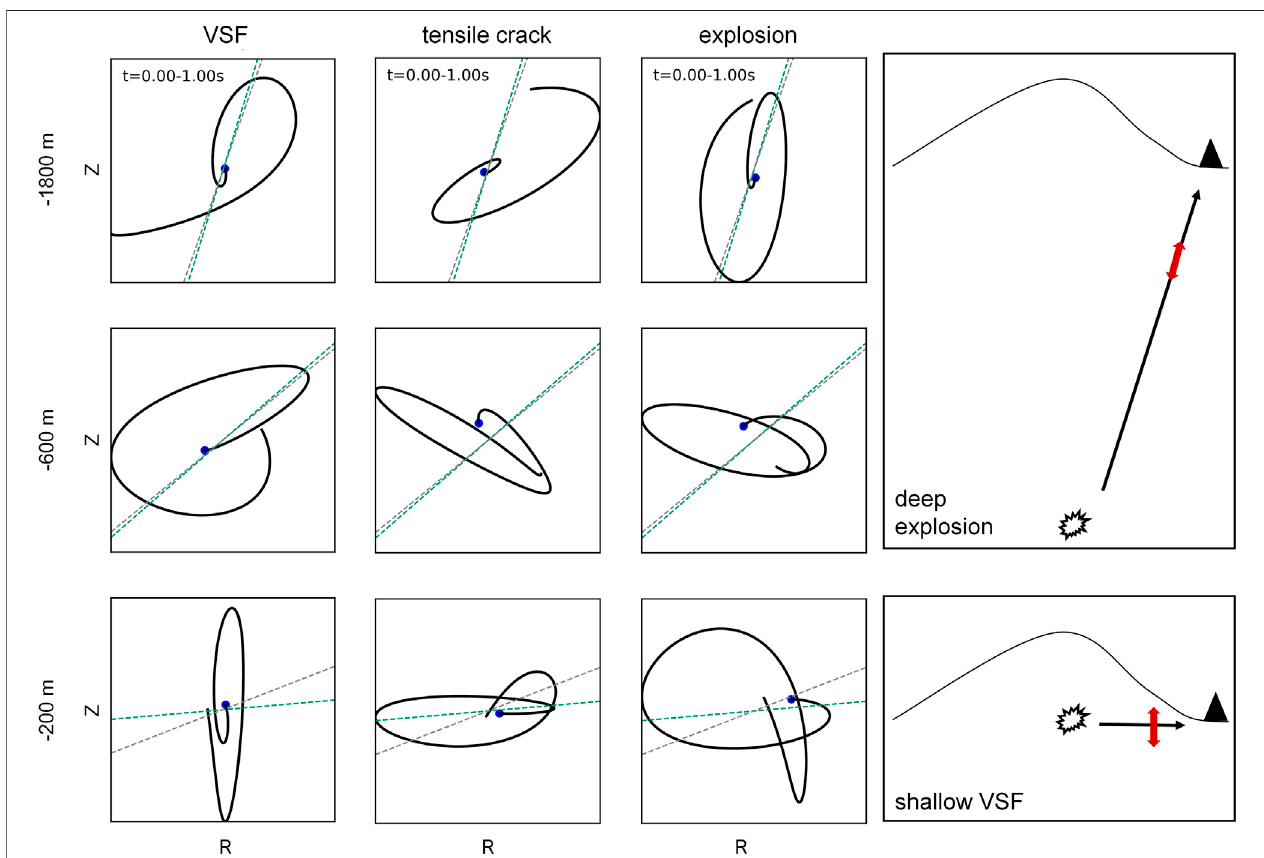
FIGURE 10 | Synthetic particle motion in the RZ-plane of the onset at LIN3 using (model 3). Each tile relates to a time window of 1 s with the radial component on the horizontal axis. The blue dot indicates the start of the time series. The fi rst column on the left refers to the vertical single force (VSF) mechanism, the second to the opening of a tensile, vertical crack and the third depicts the particle motion of an explosion. Each row corresponds to a speci fi c source depth. The green dashed line markstheapparentincidentanglecalculatedforastraightraypathconsideringthesourcereceivergeometryandthegraydashedlineincludesthecorrectionforthe in fl uence of re fl ections and wave conversions at the surface (Müller, 1990). The tiles on the right show a shallow VSF and a deep explosion, which both result in a dominating vertical motion.